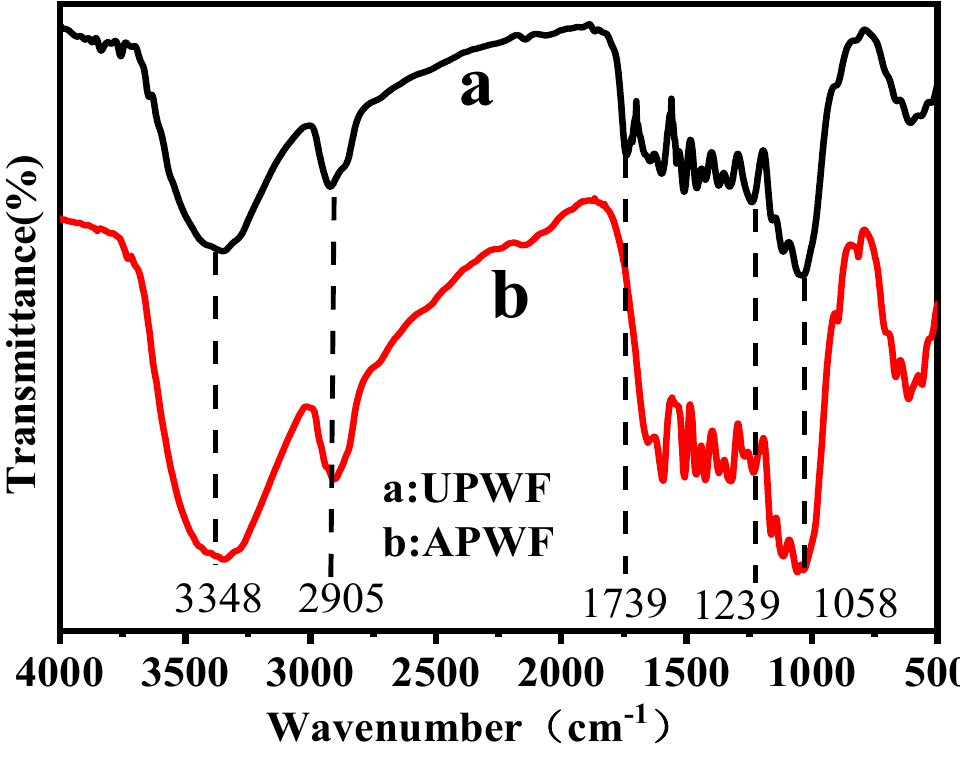
Figure 3. Infrared spectra of ( a ) untreated PWF, ( b ) alkali and peroxide treated PWF.